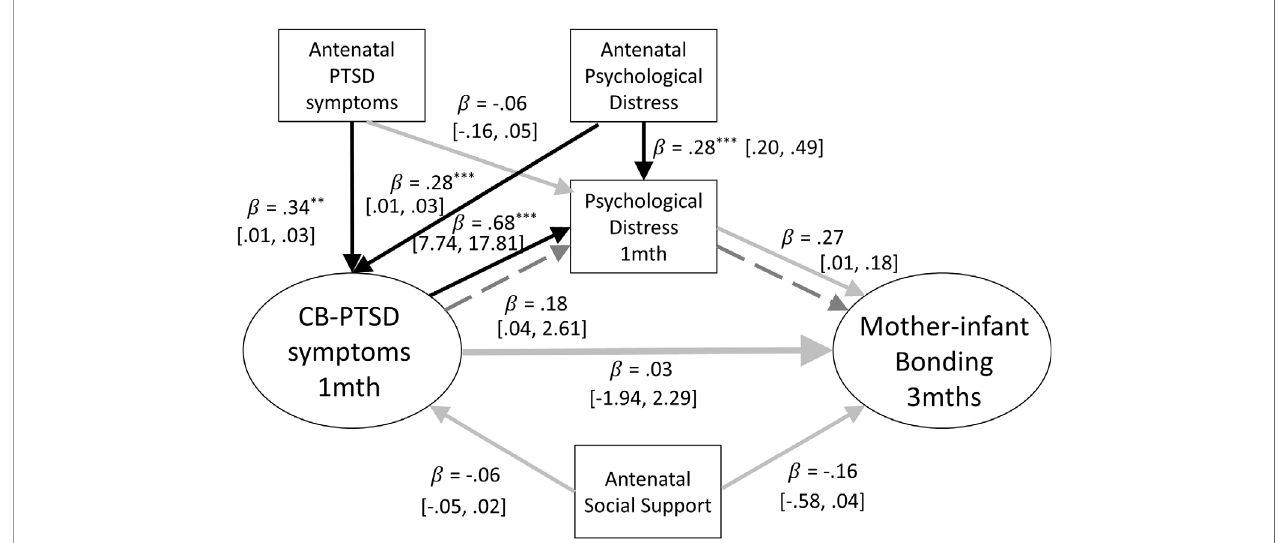
FIGURE 4 | Path model of the mediation of the relationship between mother-infant bonding at three months and postpartum PTSD symptoms at one month by concurrent psychological distress. Antenatal social support and PTSD symptoms are also included as covariates. Black lines indicate signi fi cant pathways, grey lines indicate non-signi fi cant pathways, dashed lines signify the indirect effect. Standardized coef fi cients and 95% con fi dence intervals are reported. PTSD-CB, childbirth- related posttraumatic stress disorder. *p < .05; **p < .01; ***p <